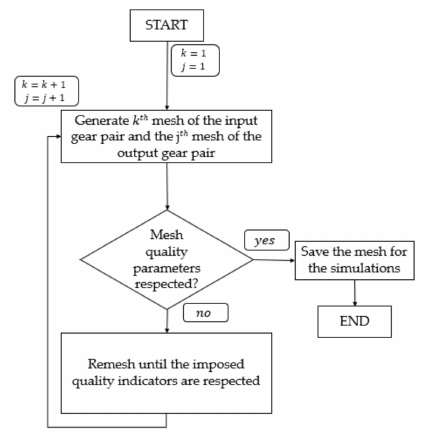
Figure 5. Scheme of the meshing